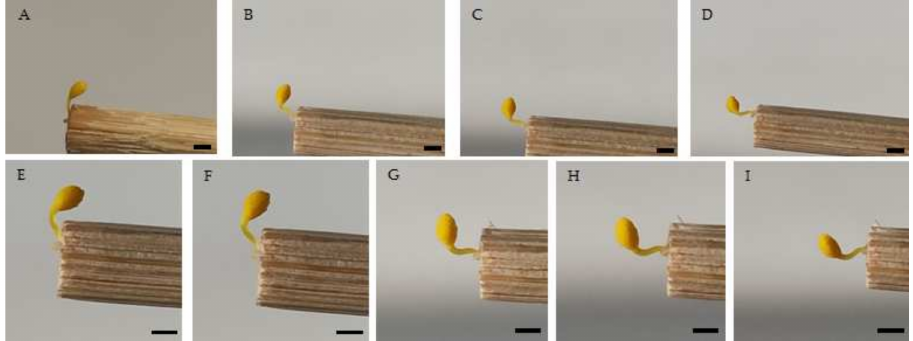
Figure 2. Photos (5 × ) of the bending movement of pollinaria. Ophrys sphegodes ( A ) just removed with toothpicks, ( B ) after 30 s, ( C ) after 90 s and ( D ) after 160 s; Dactylorhiza sambucina ( E ) just removed with toothpicks, ( F ) after 10 sec, ( G ) after 15 s, ( H ) after 25 s, and ( I ) after 35 s. After photo ( D , I ) no further bending movements were observed. Scale bar: 1